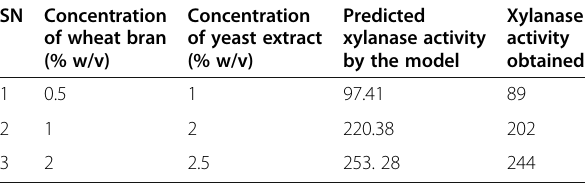
Table 4 Factor settings for validation experiment and the predicted and actual xylanase activity